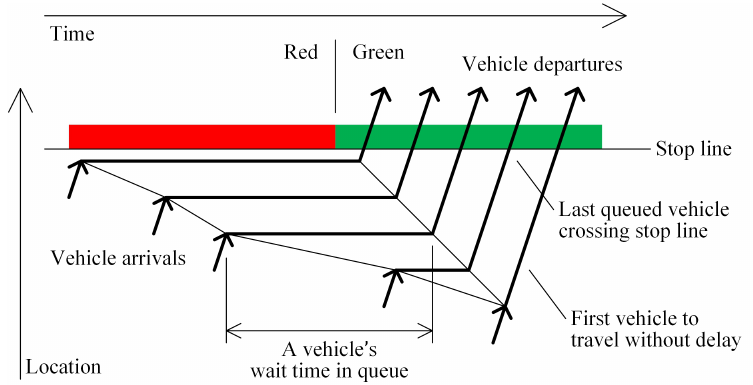
Figure 2. Basic relationship between vehicle arrivals and